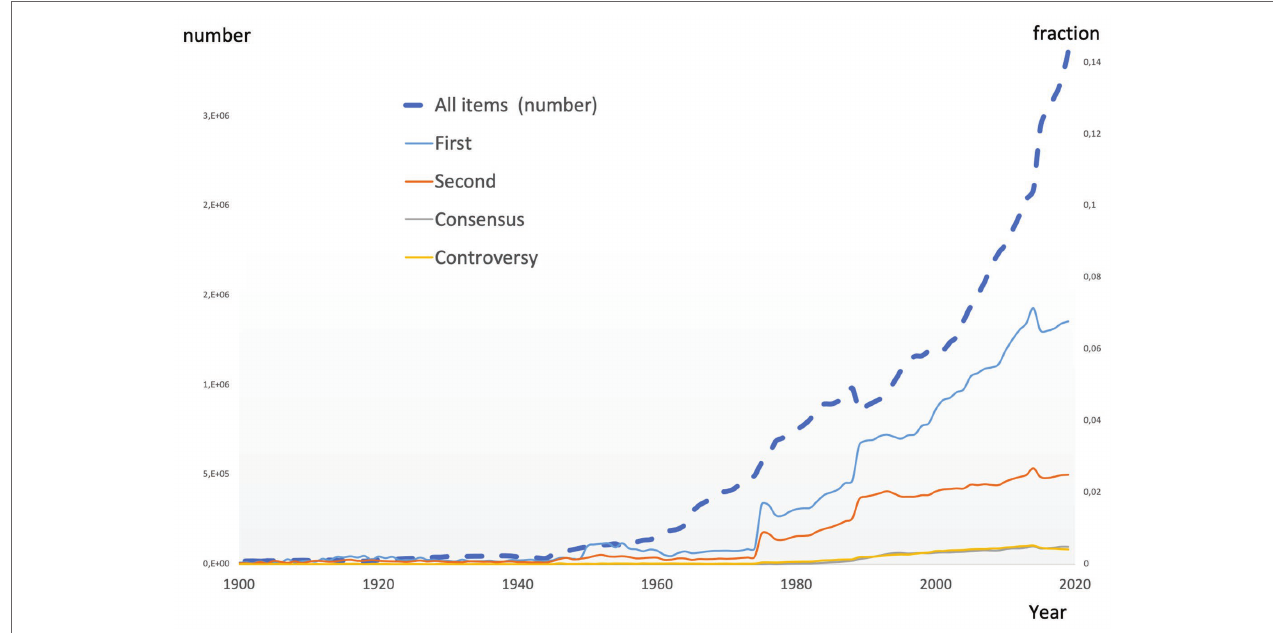
FIGURE 1 | Dotted line: time course of the number of publications (all items) since 1990 (left axis). Source: Web of Science. Drawn lines indicate the number of publications (source: PubMed, search items “first,” “second,” “consensus,” and “controversy”) mentioning “first” (blue), “second” (orange), “consensus” (gray), or “controversy” (yellow) as a fraction of the total number of publications (“all items,” right